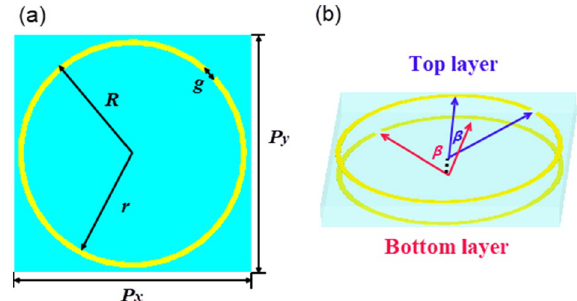
Figure 1. ( a ) The front view of structure in the xoy plane. For the top layer of copper SRR inlaid on the F4B substrate, the specific geometrical parameters of the structure are R = 4.8 mm, r = 4.56 mm, g = 0.4 mm, and P x = P y = 10 mm. ( b ) Schematic of the structure. The two identical copper layers are rotated by an angle of 2 β , and β = 45° in the